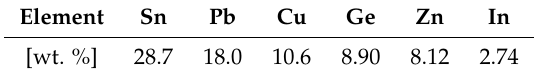
Table 1. Composition of GeIn dross used in experiments.